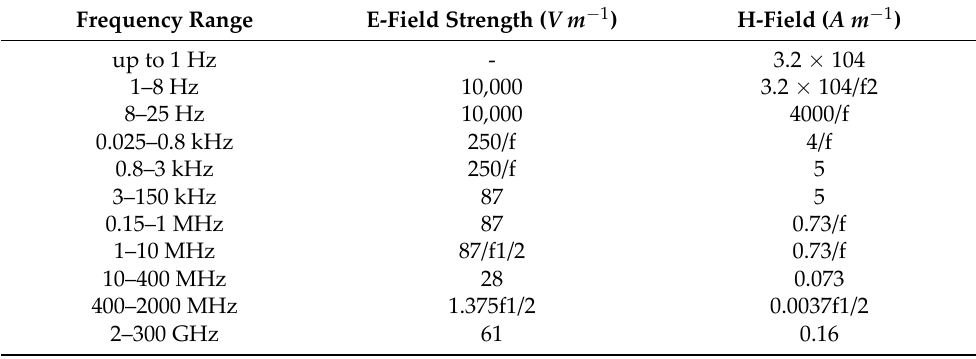
Table 1. ICNIRP guidelines’ reference levels for general public exposure